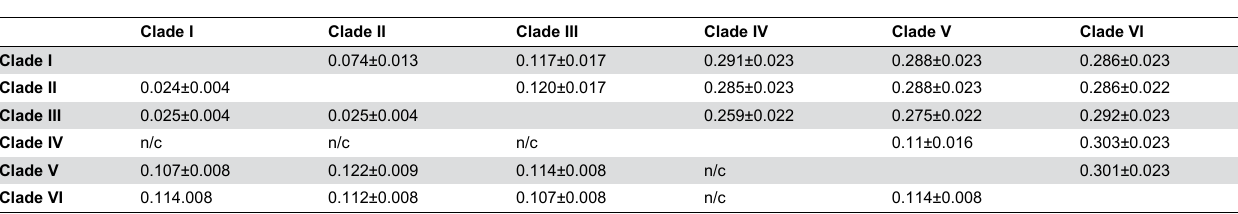
Values above the diagonal refer to the 28S rRNA gene and those below to the 18S rRNA